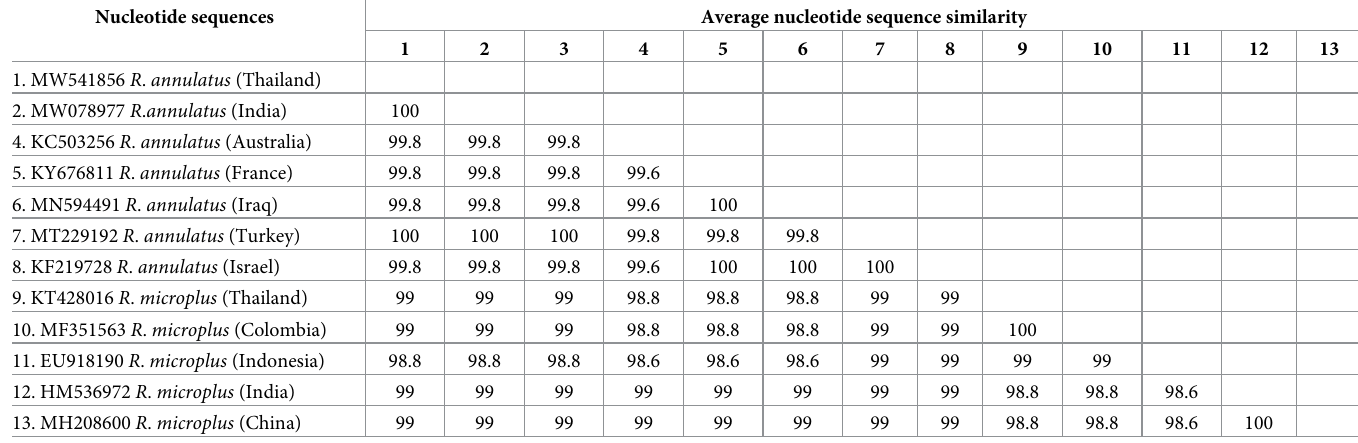
Table 1. Similarity of 16S rRNA gene sequences isolated from R . annulatus in this study with other ticks obtained from the NCBI database. Nucleotide